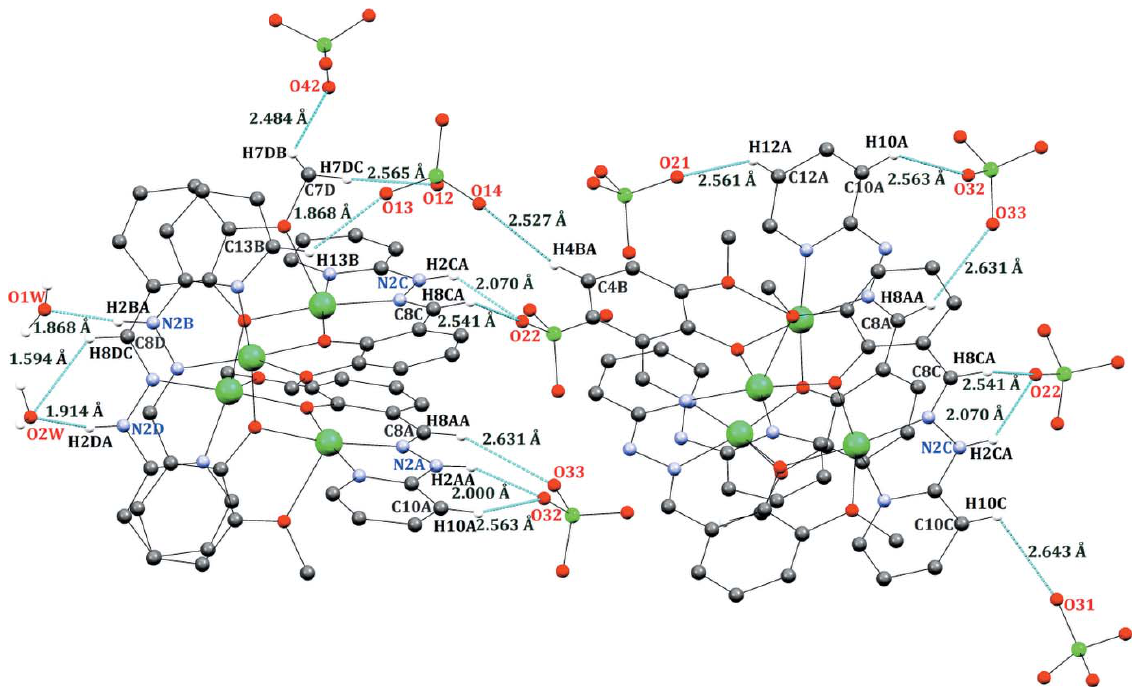
Figure 3 Intermolecular N—H (cid:2)(cid:2)(cid:2) O and C—H (cid:2)(cid:2)(cid:2) O hydrogen bonding (drawn as dotted lines) between the tetranuclear complex, perchlorate counter-ions and water molecules of crystallization.